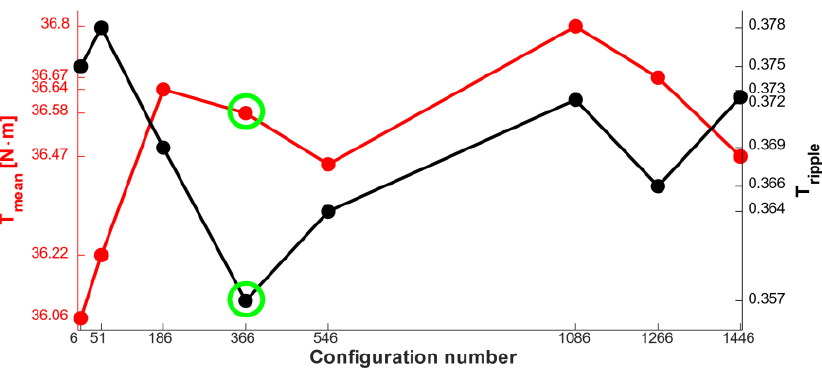
Figure 10. T mean (red) and T ripple (black) of the best configurations. The solution chosen as the best one (number 366) is circled by green.